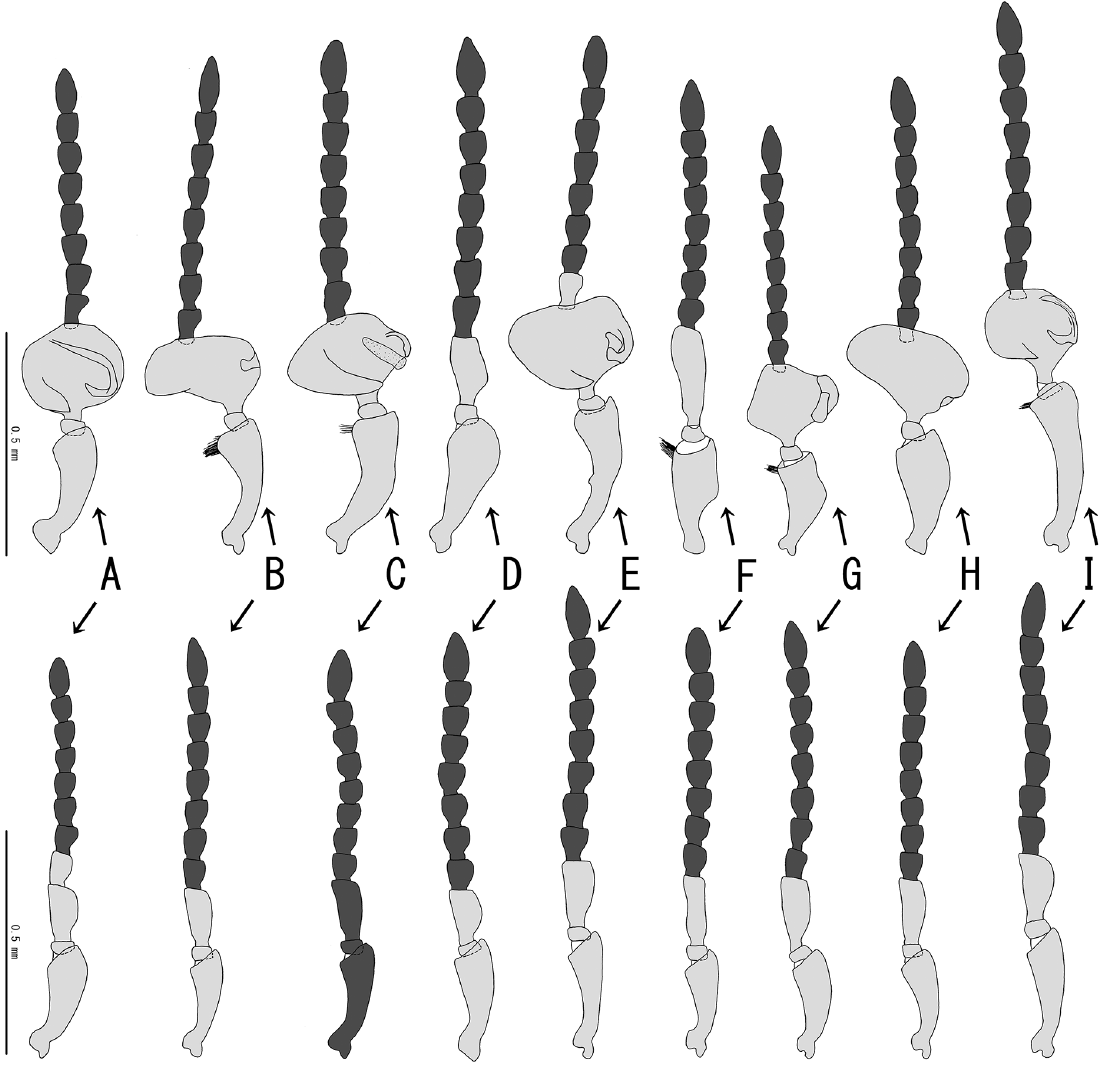
Fig. 7. Left antennae of Laius spp. (above: male; below: female). A . Laius baliensis sp. nov. (paratype). B . L. andamanensis sp. nov. (paratype). C . L. rodriguesensis sp. nov. (paratype). D . L. maai